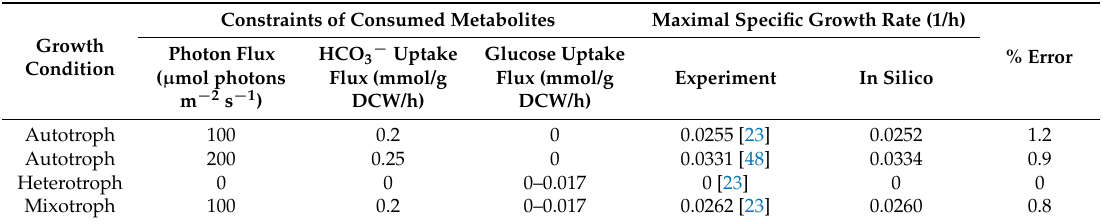
Table 3. Comparison of in silico and experimental